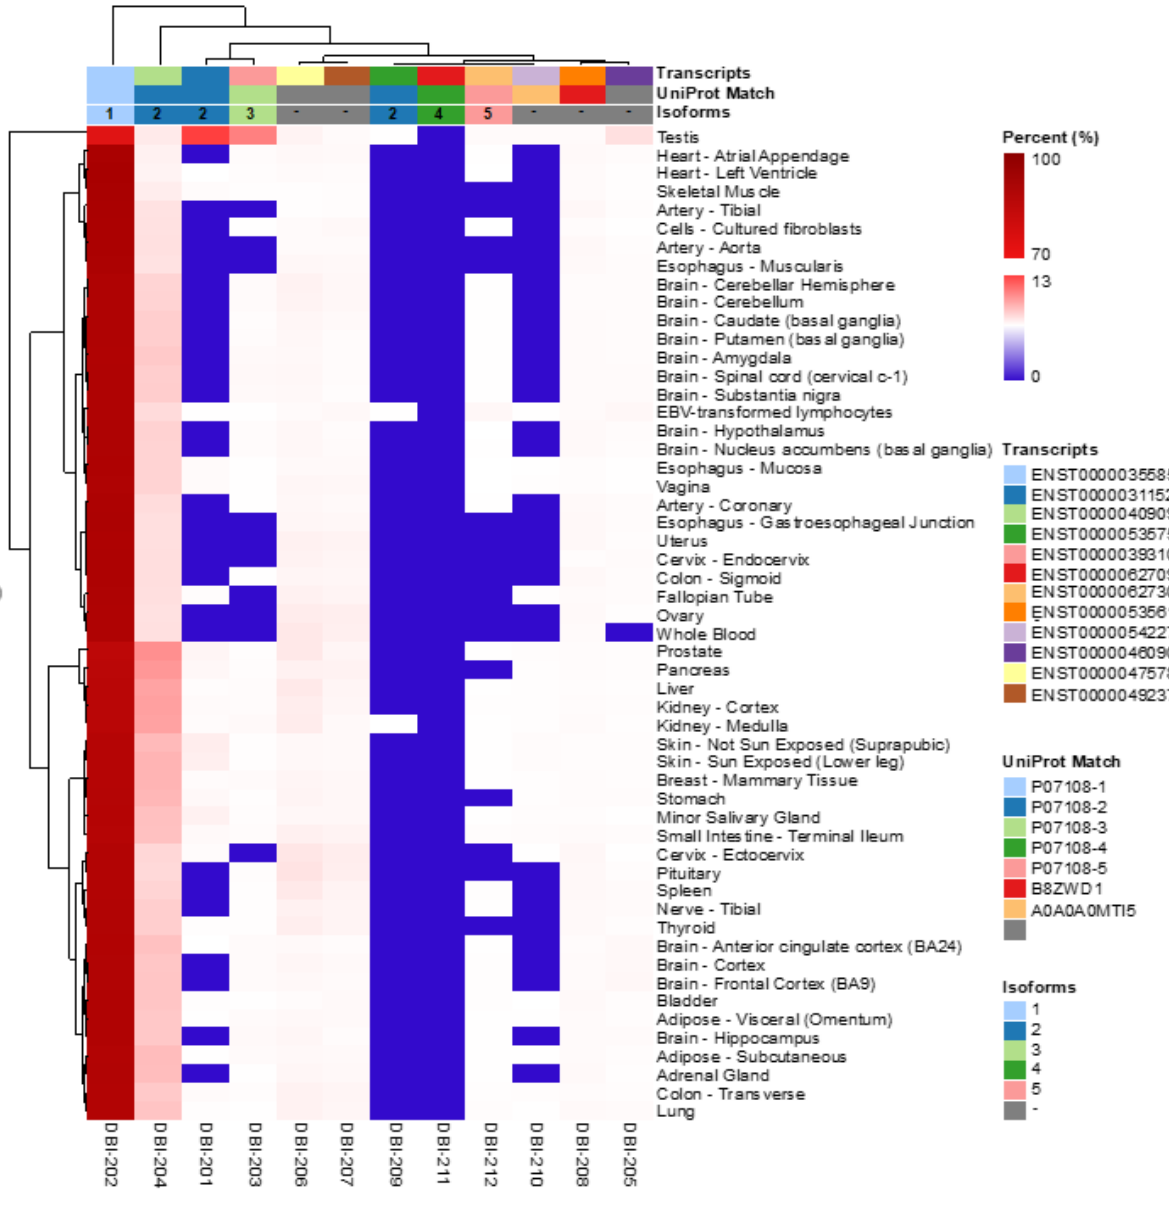
FIGURE 2: The proportion of DBI isoforms in human tissues. The data were obtained from GTExPortal database (https://www.gtexportal.org/home/) on April, 7th 2021. Expression values are shown in percentages of the different isoforms in the corre- sponding